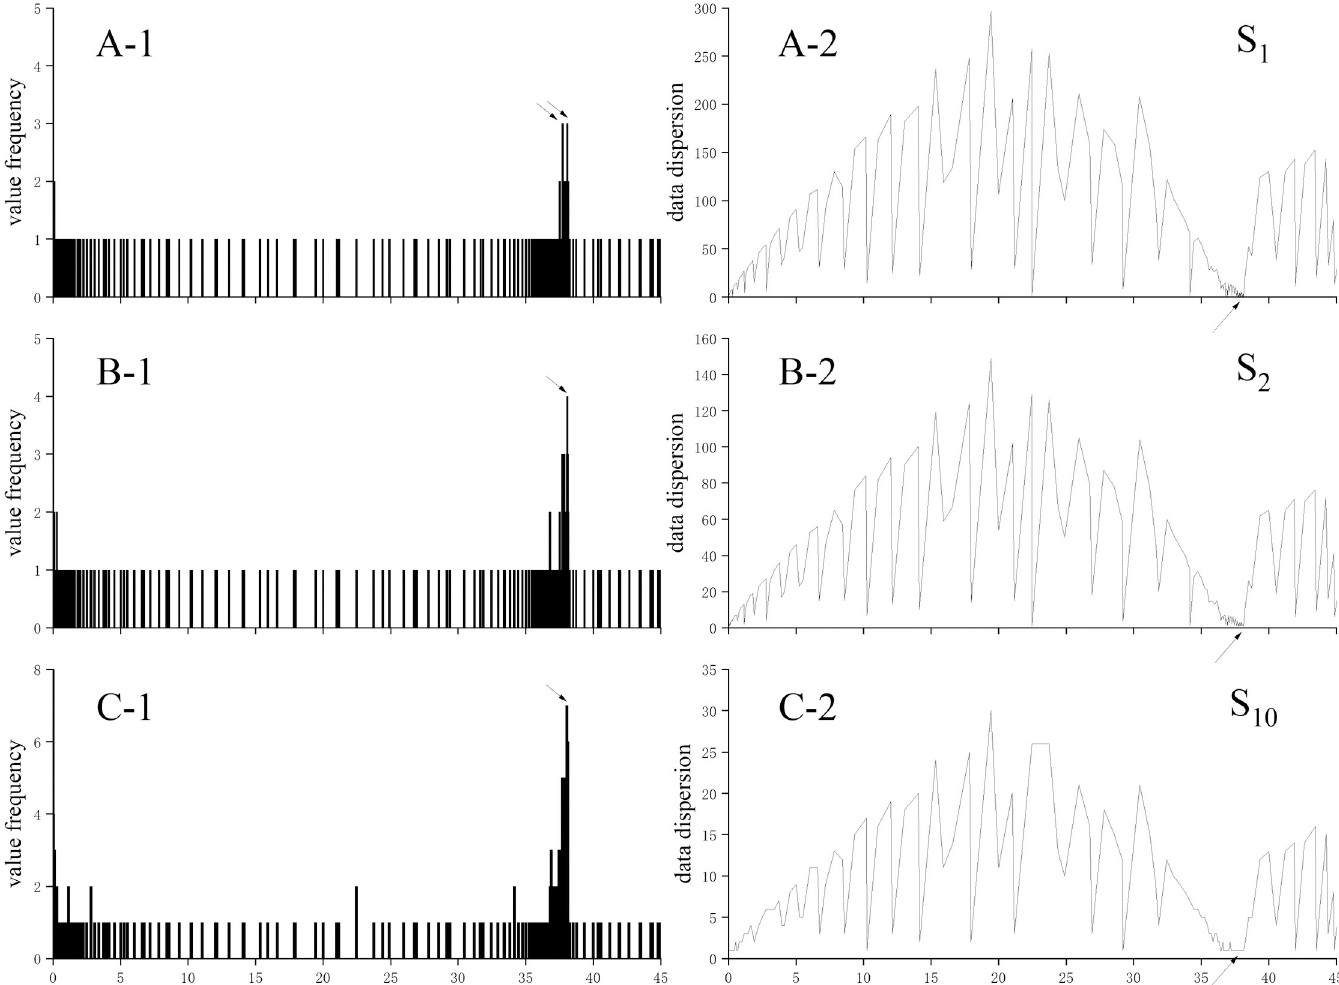
Fig 3. Value frequency and data dispersion changes with difference value domain segmentation. Fig A shows the variation of the value frequency of different segmentation values with a histogram. Fig B shows the data dispersion for different segmentation values. The smaller the dispersion, the better the relative continuity of the values in the data